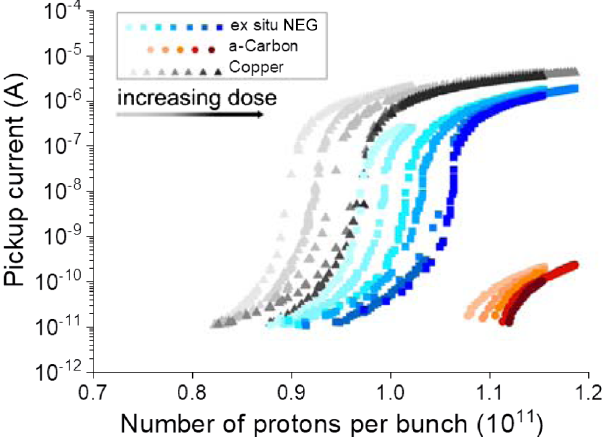
FIG. 11. Accumulated electron dose effect on the pressure trends at 450 GeV as a function of the number of protons per bunch, in logarithmic